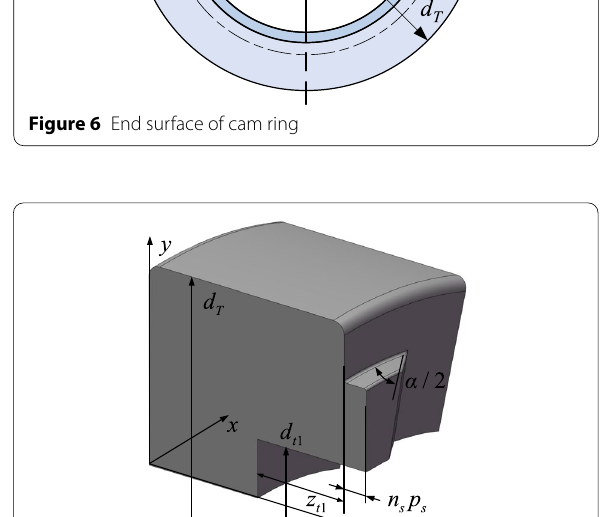
Figure 5 Schematic diagram of carrier